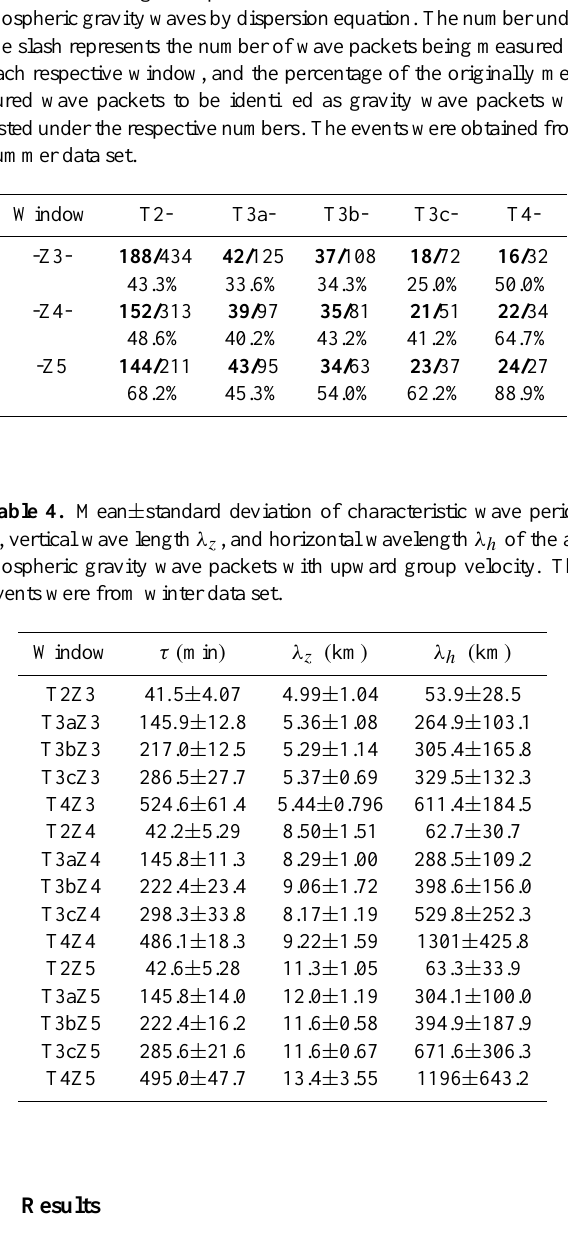
u h = 38 . 7 m/s, φ uh = 77 . 9 ◦ for the winter data, and u h = 9 m/s, φ uh = 290 ◦ for the summer data. As explained in Sect.